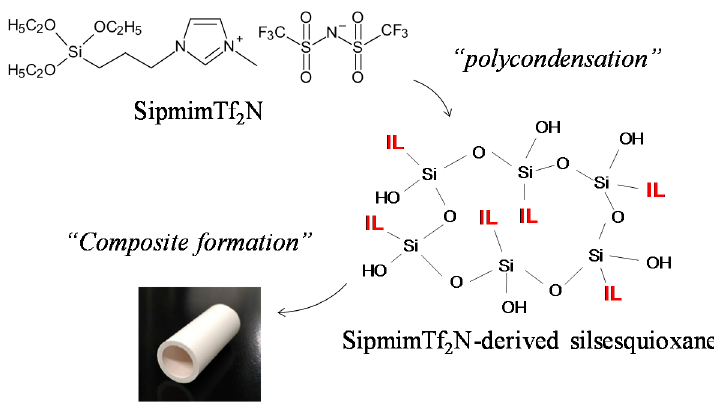
Figure 1. Concept of an ionic liquid organosilica (ILOS) membrane.